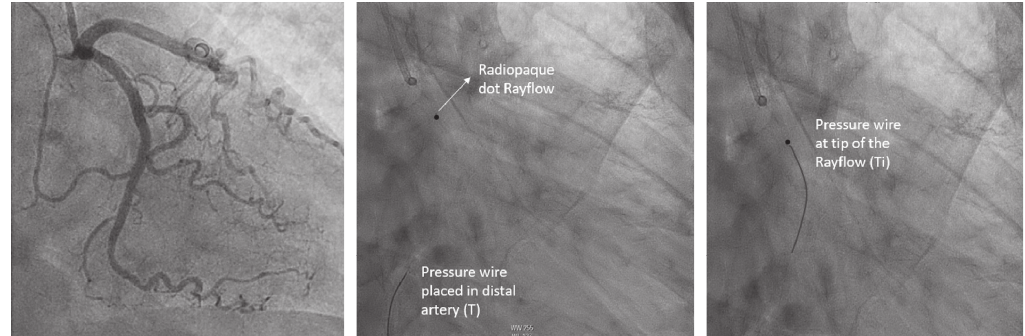
Figure 2: Pressure wire and infusion catheter position. In the left panel, a normal circumflex artery is shown. The middle panel shows the pressure wire X, which is placed in the distal coronary artery, and the Rayflow catheter in the proximal artery. The Rayflow is visible by a radiopaque dot at the tip. In this position, the measurement starts. The right panel shows the position of the pressure wire when it is pulled back towards the inner side holes of the Rayflow catheter. Now the infusion temperature is assessed. T i : the infusion temperature of the saline as measured at the infusion holes of the Rayflow catheter; T : the distal coronary temperature after complete mixing of blood and saline measured by the pressure wire after calibration to body temperature.